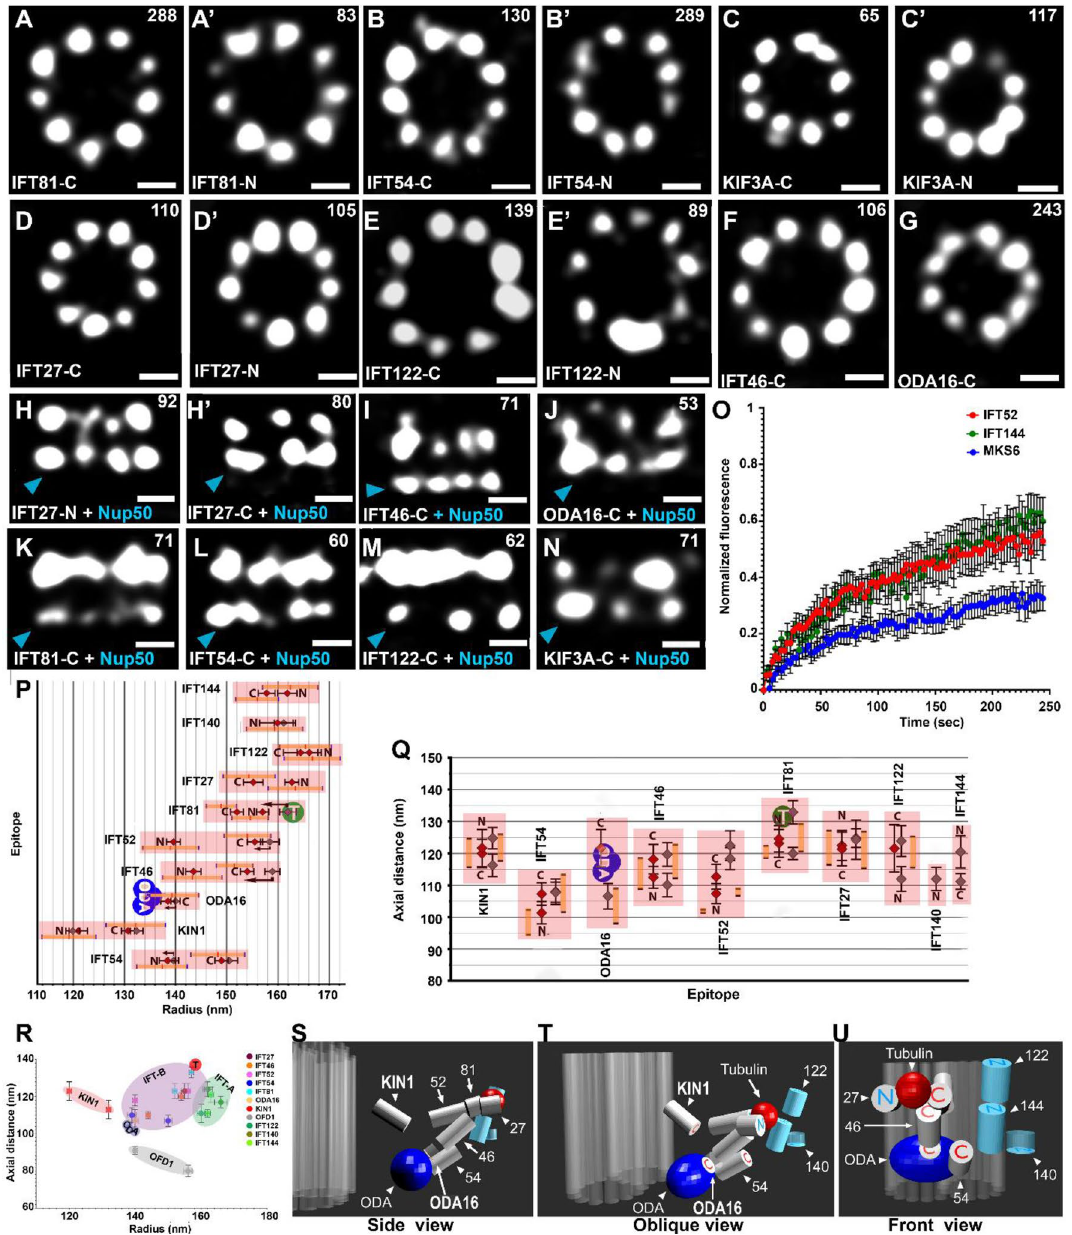
Figure 2. Localization of IFT particle proteins. ( A–N ) STORM images of top and side (lateral) views of N- or C-terminally 3HA tagged IFT proteins, KIN1/KIF3A kinesin and an adaptor protein ODA16 as indicated. ( O ) FRAP analysis of two fluorescent IFT proteins: IFT52 and IFT144 compared to MKS6, a TZ component. ( P ) Radial positions of IFT proteins localized using direct (indicated in color) and indirect (in grey) staining. Arrows indicate differences between the two localization methods. ( Q ) Axial positions of IFT proteins relative to NUP50 (indicated by a blue arrowhead). In ( P,Q ) Predicted positions of tubulin (T) and outer dynein arms (ODA) cargo are indicated. Yellow bars in ( P,Q ) show the uncertainty of epitope locations. ( R ) Graph showing radial versus axial positions of all investigated IFT proteins. Means ± SEM are shown for each protein. ( S–U ) 3D model of IFT proteins’ localization. Side, oblique, and front views are provided. Scale bars in ( A–N ), 100 nm. In panels ( A–N ), the numbers of rings (or side views) used to calculate the average radius (or axial distance) of each protein are indicated (top right). The rings/side views were collected from at least 10 different cells in at least three independent